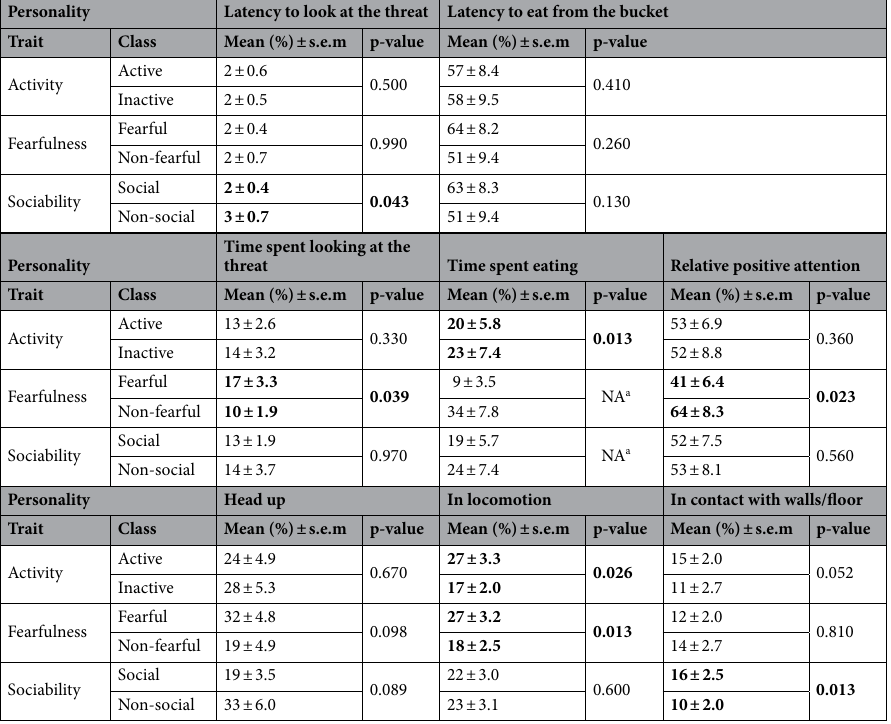
Table 3. Behavioural measures obtained in the Attention Bias Task under the reference conditions. Results are presented according to the personality traits and classes of personality trait. Results are expressed in proportion of trial duration (120 s), except for Relative positive attention, which is expressed in proportion of heifer’s total time spent at looking at the stimuli. Significant results are written in bold. a NA (not applicable) instead of an exact p-value is indicated in case of interaction effects between personality